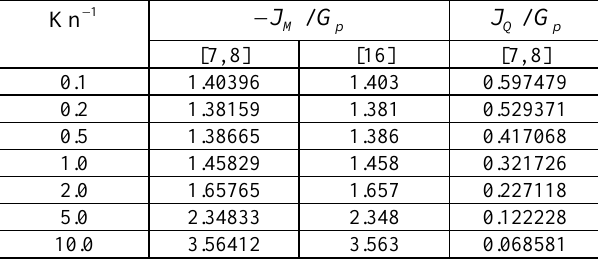
Table 4. The mass and heat fluxes in [9,